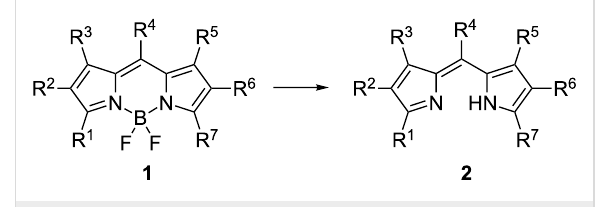
Scheme 1: Conversion of F -BODIPYs 1 to the parent dipyrrins 2 .